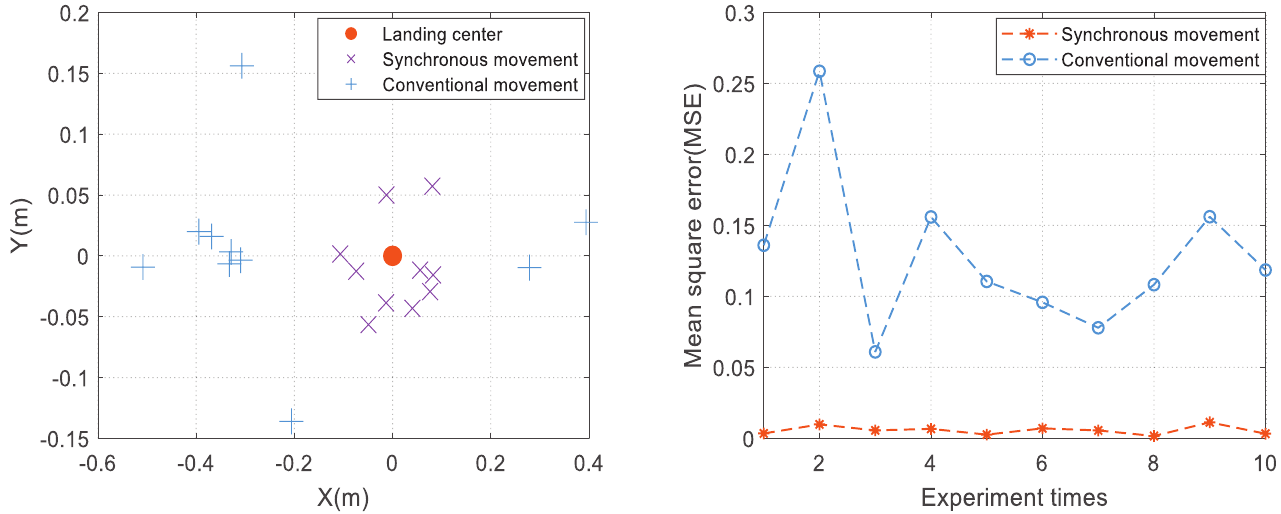
Figure 11. Landing accuracy of UAV–USV synchronous movement and conventional movement under the condition of USV pitching